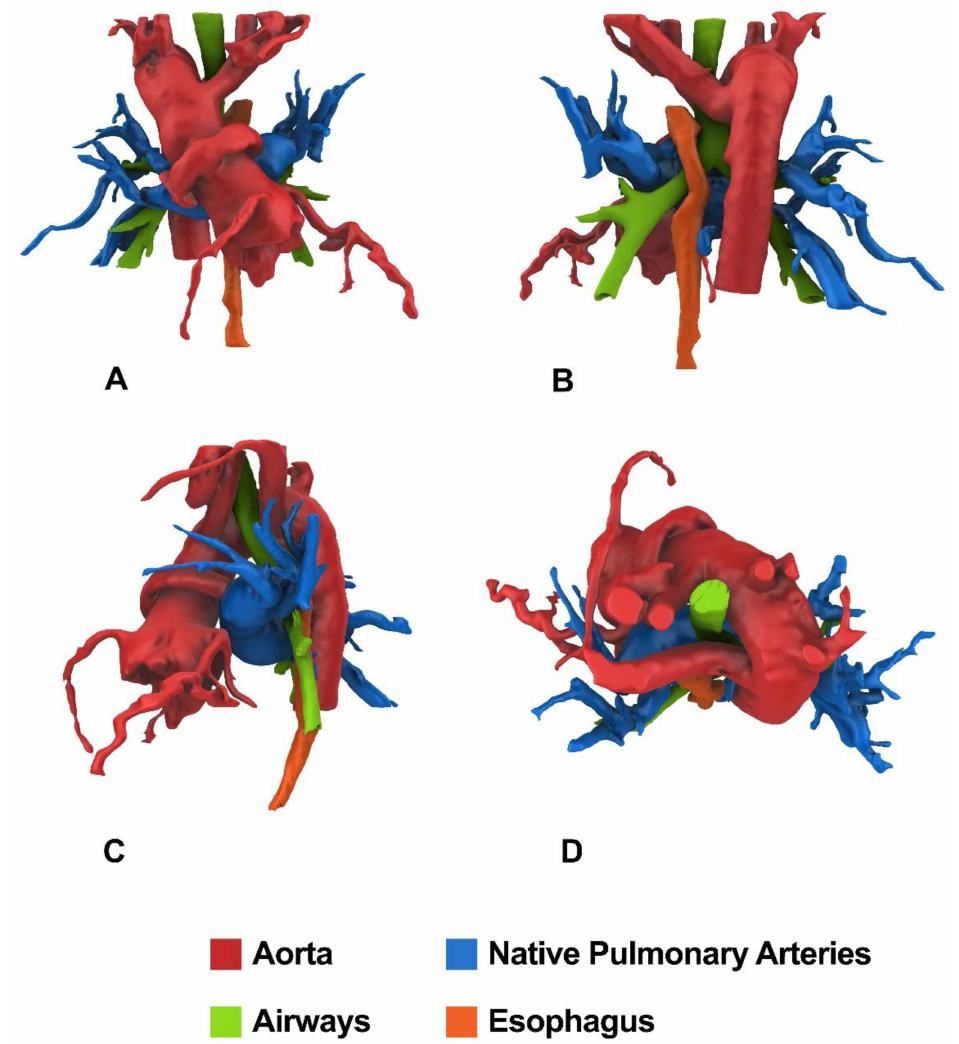
Figure 4. CT imaging of the patient who underwent pulmonary artery rehabilitation and subsequent unifocalization with a central shunt. Colored rendering for Frontal ( A ), Posterior ( B ), Lateral ( C ), and Top ( D ) views obtained from CT images with semi-automatic 3D segmentation